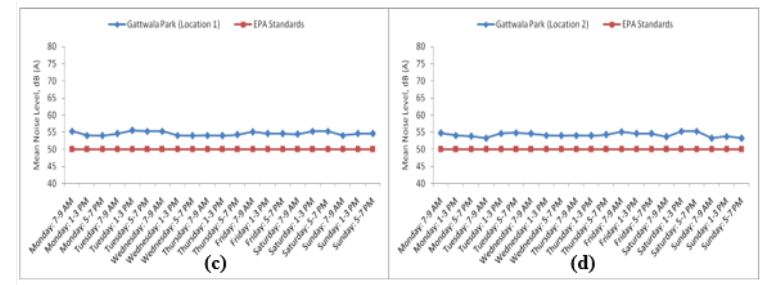
Figure 3: Comparison of Average Noise Level against PEPA Standard (Site 1)